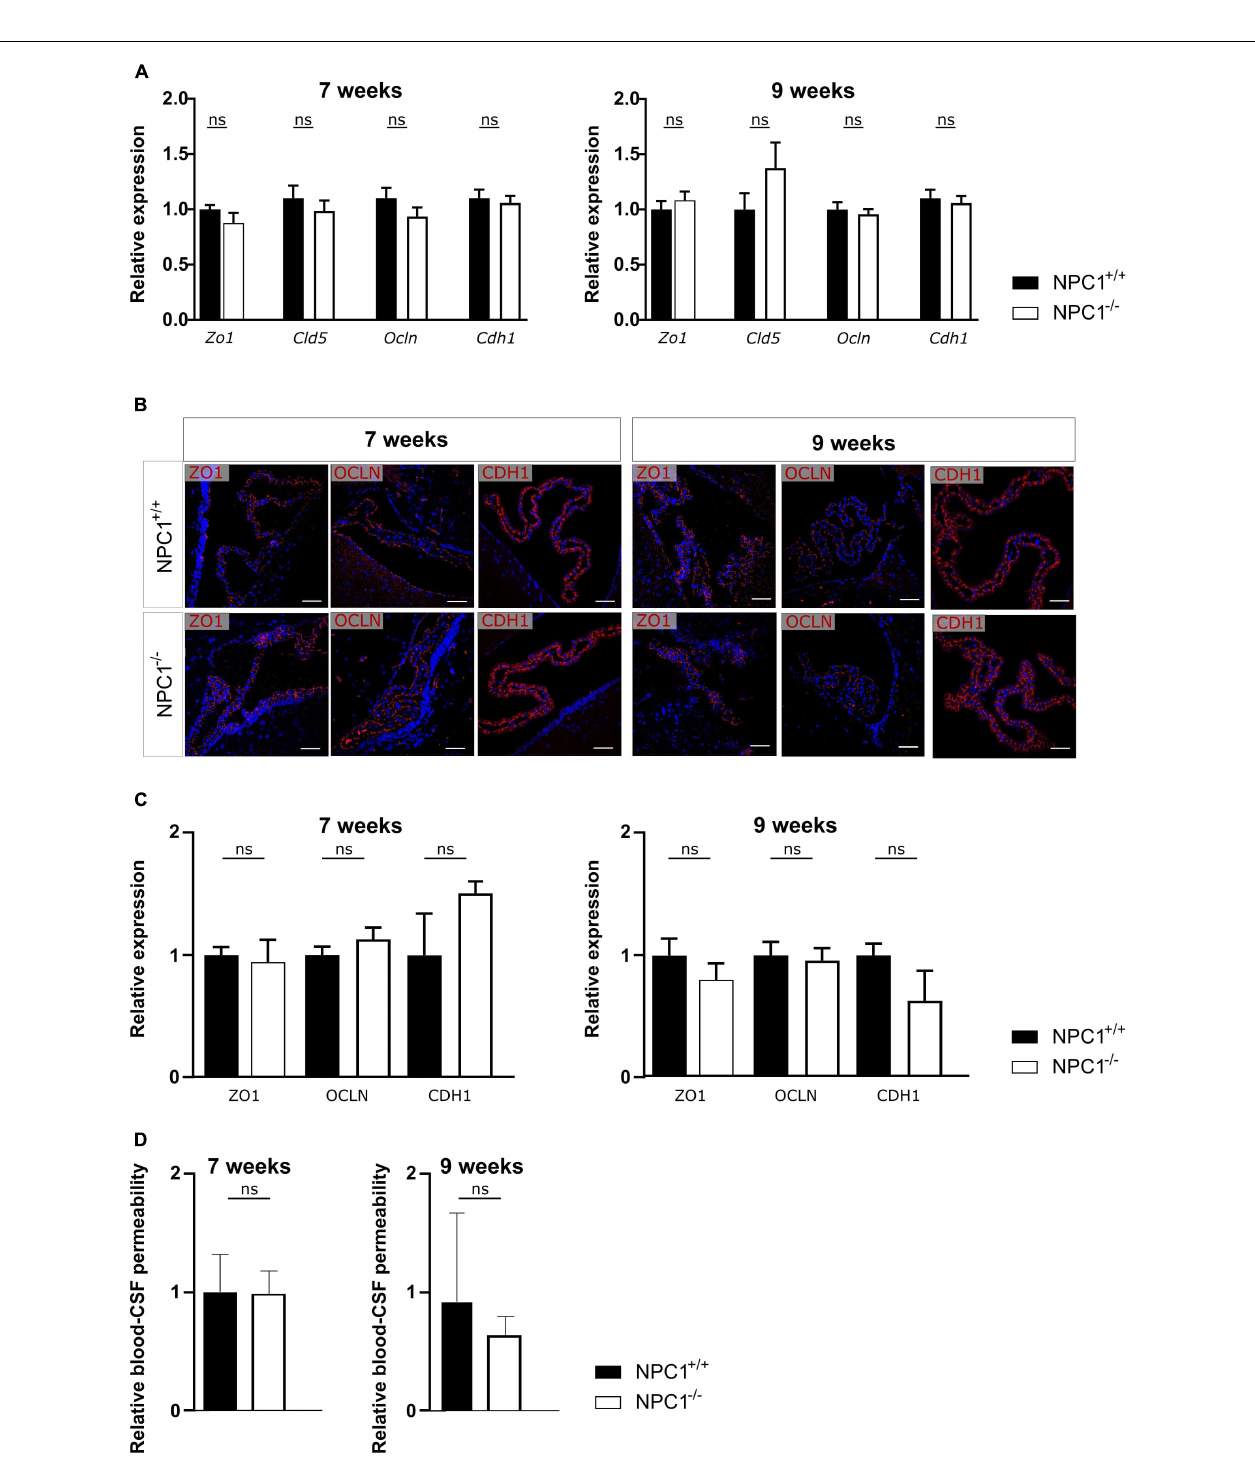
FIGURE 2 | NPC1 − / − pathology has no effect on blood-cerebrospinal fluid (CSF) barrier integrity. (A) qRT-PCR analysis of choroid plexus isolated from NPC1 + / + and NPC1 − / − of 7 and 9 weeks old mice ( n = 11–13). (B) Representative images of ZO1, OCLN, and CDH1 staining (red) of the choroid plexus of NPC1 + / + and NPC1 − / − mice of 7 and 9 weeks old. Cell nuclei are counterstained with Hoechst (blue) ( n = 4–5). Scale bar represents 20 µ m. (C) Quantification of the ZO1, OCLN, or CDH1 signal at the tight junctions of the choroid plexus epithelial cells. (D) Relative blood-CSF barrier permeability of 7 and 9 weeks old NPC1 + / + and NPC1 − / − mice of ( n = 5–7). Data are shown as mean ± SEM. Statistical analyses on datasets were performed by Mann–Whitney test (ns: non-significant).